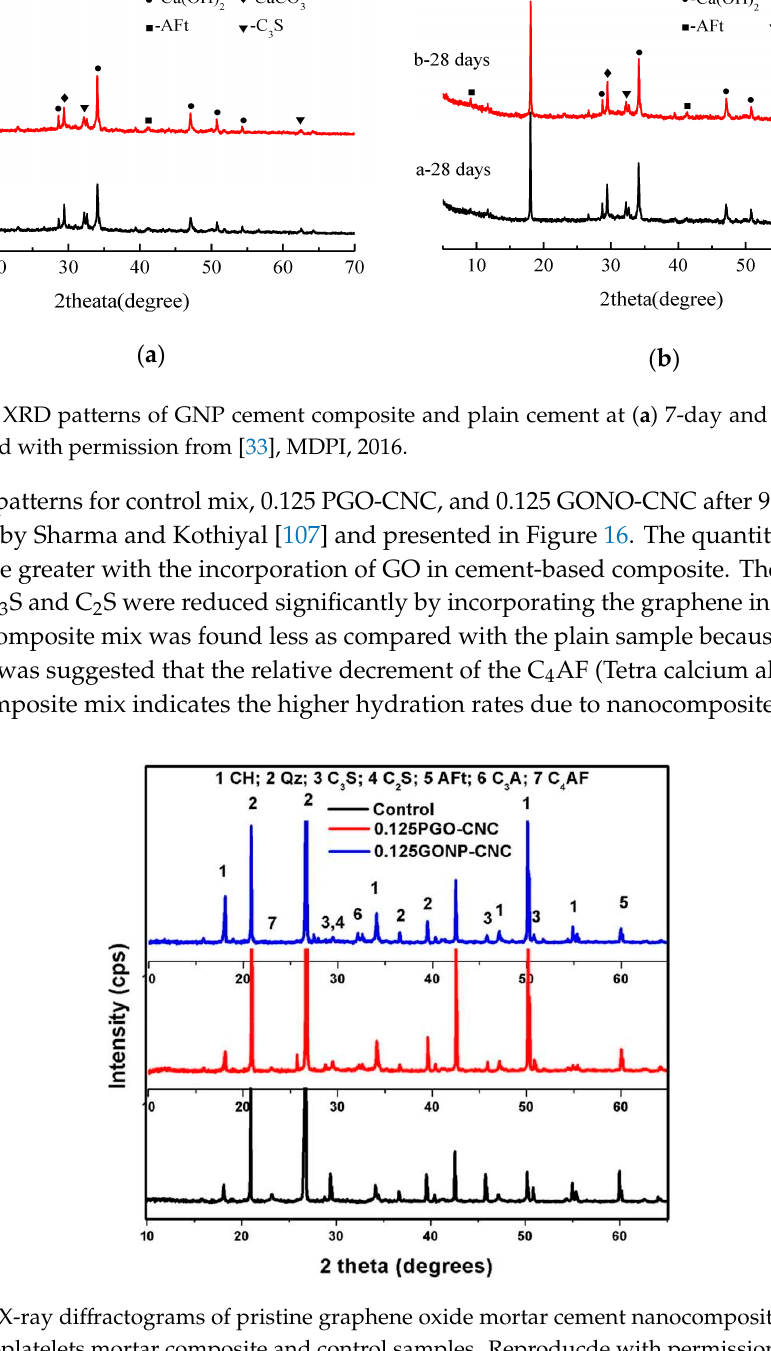
Figure 16. X-ray diffractograms of pristine graphene oxide mortar cement nanocomposite, graphene oxide nanoplatelets mortar composite and control samples. Reproducde with permission from [107], Elsevier, 2016.